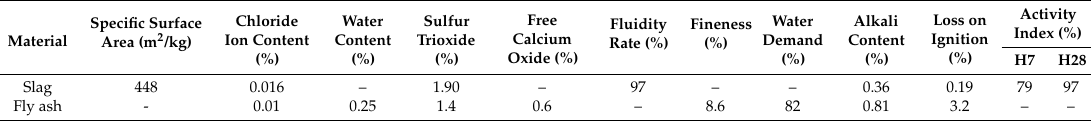
Table 2. Performance index summary of slag and fly